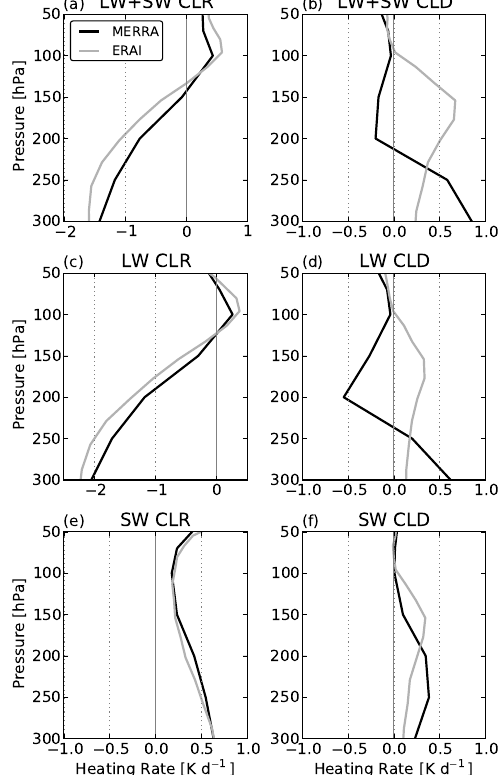
Fig. 5. Profiles of clear-sky (left column) and cloud (right col- umn) radiative heating rates for (a) – (b) long-wave plus short-wave, (c) – (d) long-wave, and (e) – (f) short-wave radiation according to MERRA (black line) and ERAI (grey line). Cloud radiative heat- ing rates are calculated as all-sky minus clear-sky. Profile values have been averaged over 5 ◦ S to 5 ◦ N for the period